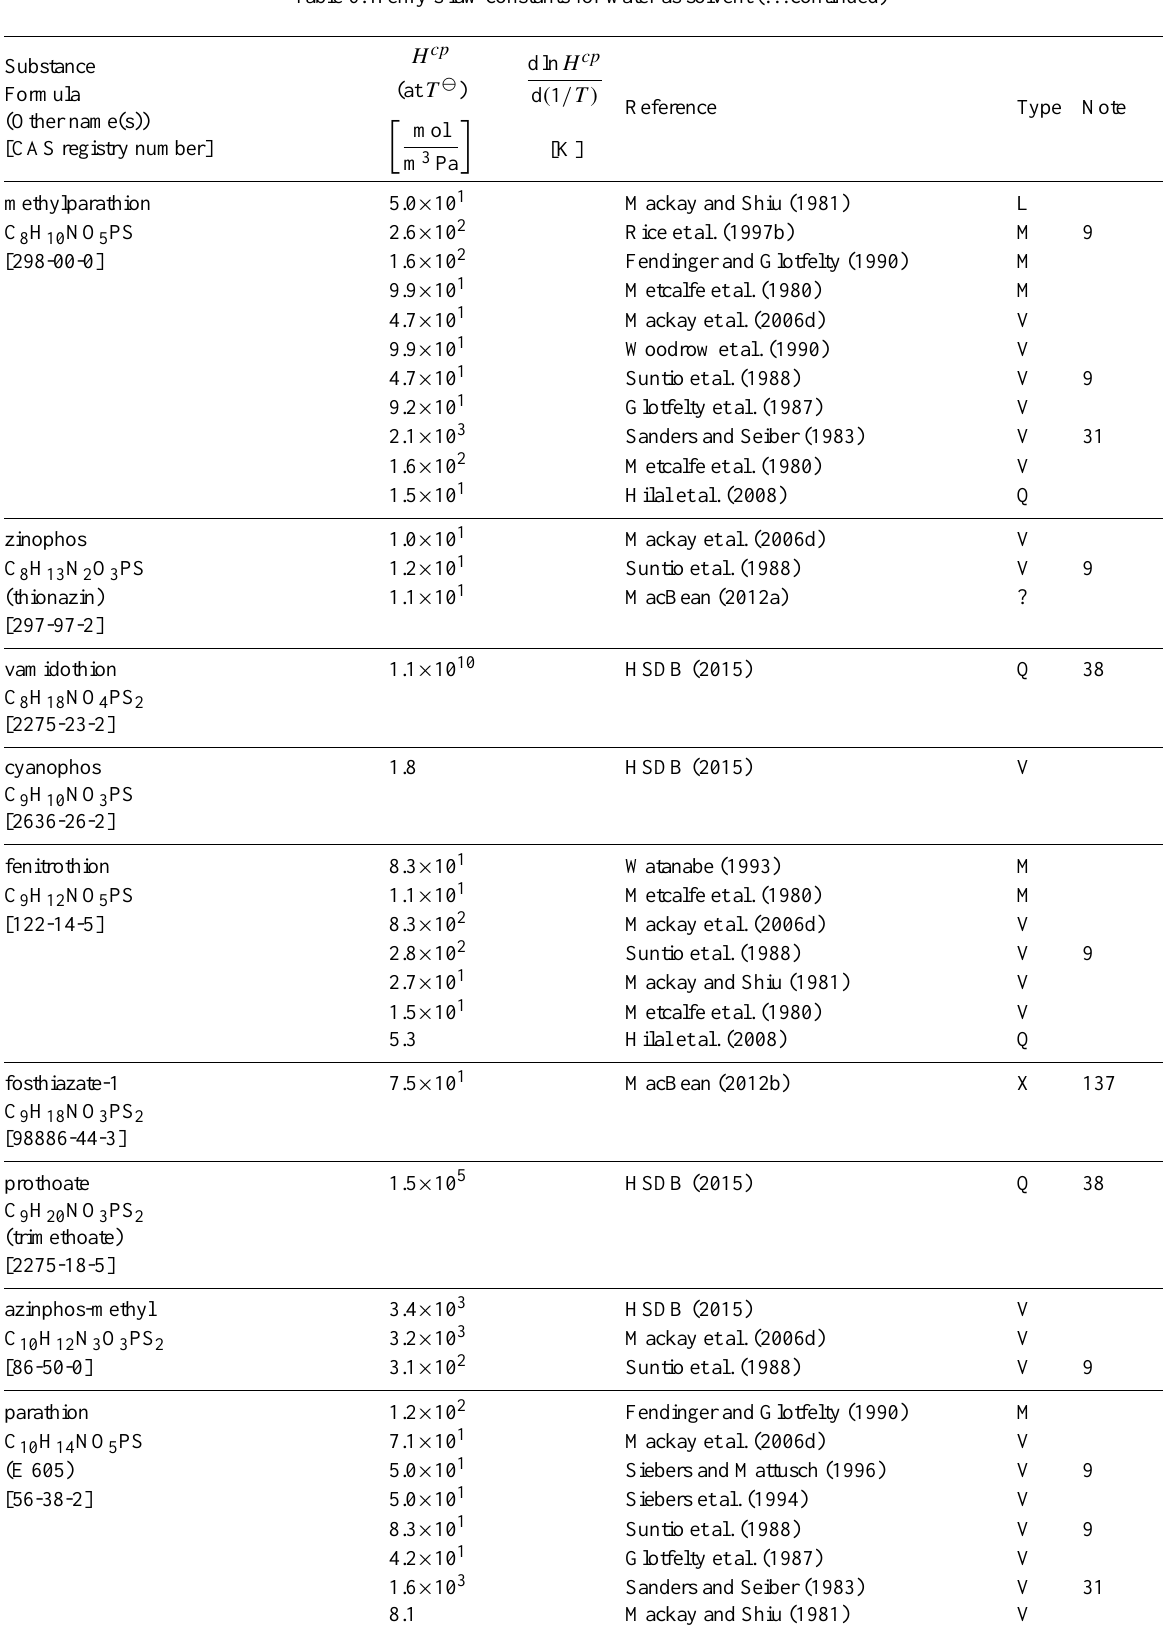
Table 6: Henry’s law constants for water as solvent